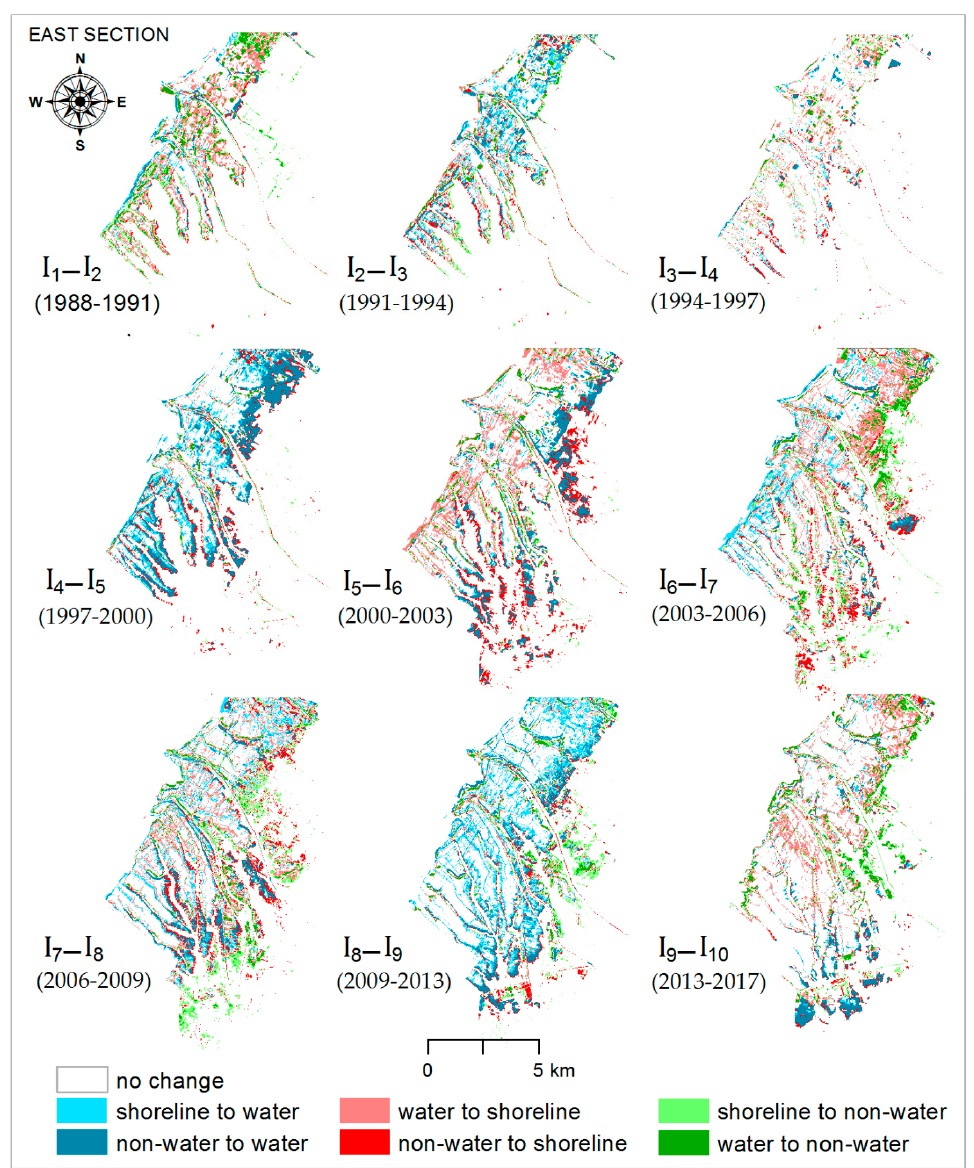
Figure 14. The spatial distribution of shoreline changes in the east section of the study area for consecutive dates. The changed area was getting larger in the recent images from 2000, up to 2017, reflecting the severity of inundation in the area.